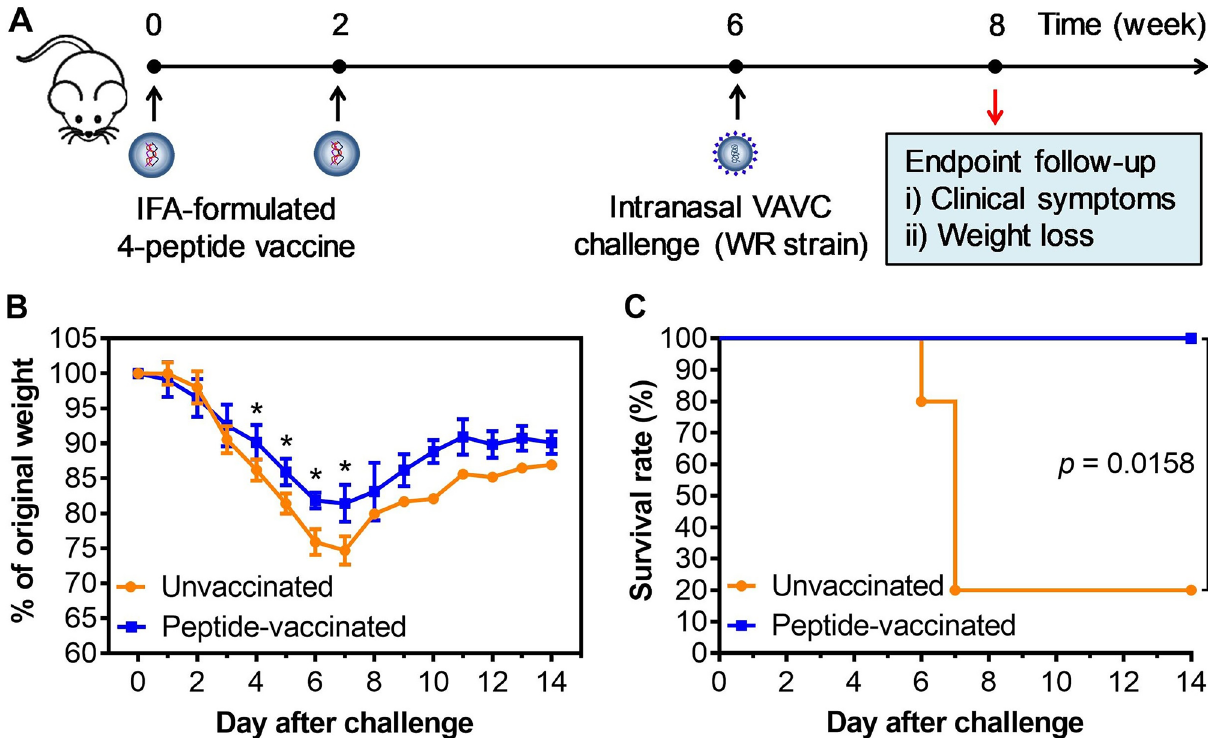
Figure 5. Survival of unvaccinated and peptide-vaccinated mice after lethal viral challenge. ( A ) Four selected peptides were formulated with IFA, and the mice were immunized with a two-dose regimen. Four weeks after the booster vaccination, the mice received an intranasal challenge with a lethal dose of VACV (WR strain). Clinical symptoms and weight loss were monitored daily for 2 weeks after viral challenge. ( B ) Weight of unvaccinated and peptide-vaccinated mice up to two weeks after the viral challenge. The asterisks (*) indicate a significant difference (p < 0.05) in weight between unvaccinated and peptide-vaccinated groups. Note that as of IACUC’s requirement, mice losing 25% of their weights were euthanized. After day 7, there was only one mouse in unvaccinated group; therefore, the difference in weight of mice between two groups were not